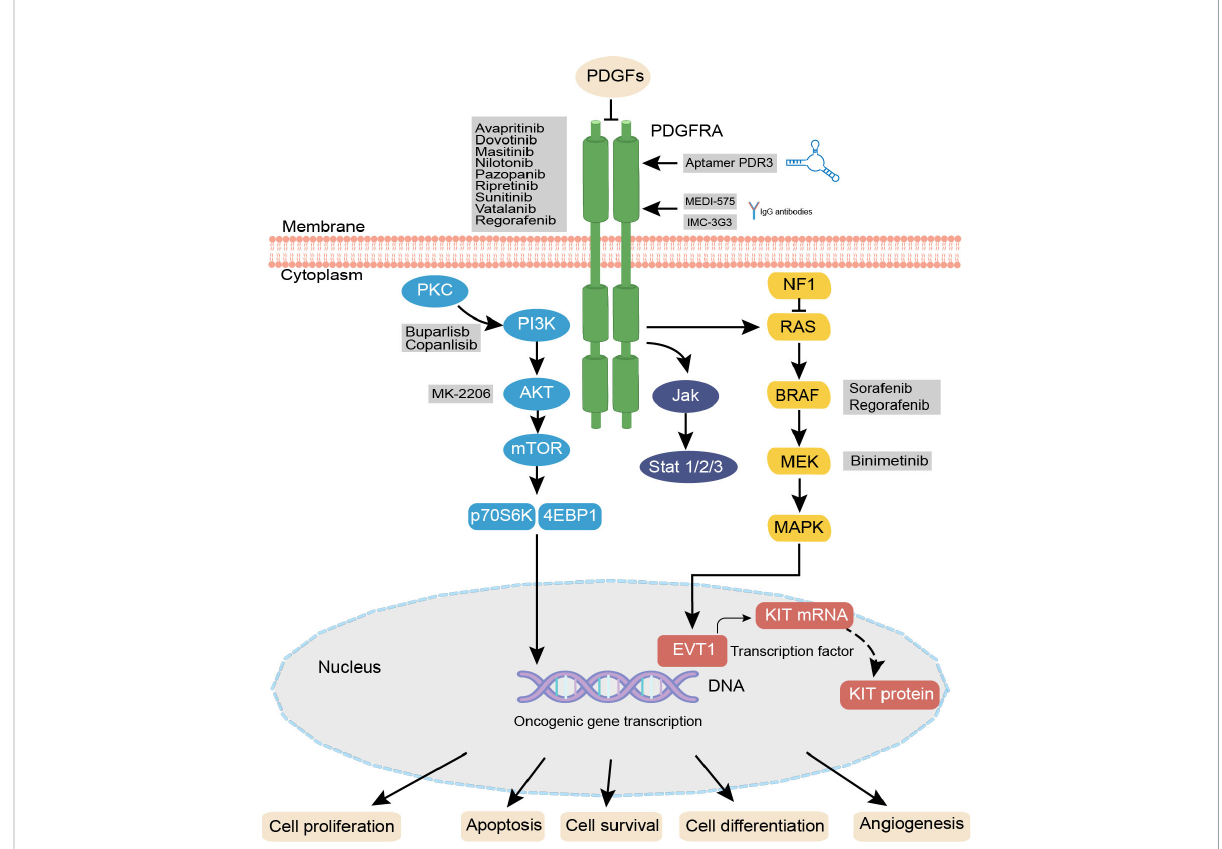
FIGURE 2 PDGF/PDGFRA signaling pathways and agent treatments. In PDGFRA mutaled GIST. PDGF isoforms bind to the related PDGFRs, initiate distinct receptor dimerization and phosphorylation, thereby activating various signaling pathways including the RAS-MEK-MAPK, PI3K-mTOR, JAK/STAT, and Notch pathway PDGFR antibodies such as INC-3G3, MEDI-575 and the speci fi c RNA aptamer PDR3 can selectively bind to PDGFRA, after binding, these antibodies or aptamers can inhibit the downstream pathways. Activation or inhibition of these pathways in fl uences cellular proliferation, angiogenesis, and apoptosis. PDGF, platelet-derived growth factor; PDGFR, platelet-derived growth factor receptor; PKC, protein kinase C; PI3K, phosphati-dylinositol 3 kinase; AKT/PKB, protein kinase B; JAK, Janus kinase; STAT, signal transducers and activators of transcription; ERK, extracellular signal-regulated kinase; MAPK, mitogen-activated protein kinase; PDR3, the speci fi c RNA